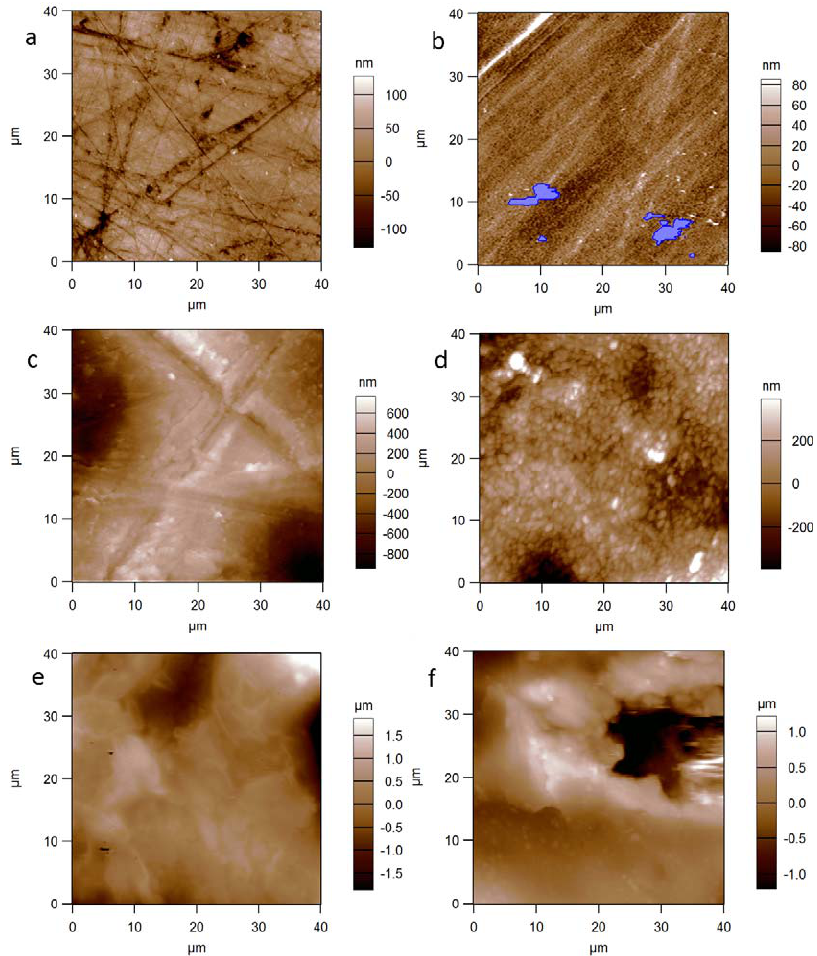
Figure 3. Representative topographic images of the materials’ surfaces: ( a ) PMMA; ( b ) silicone; ( c ) PE; ( d ) alumina; ( e ) GCA; ( f ) GCB. Materials 2018 , 11 , x FOR PEER REVIEW